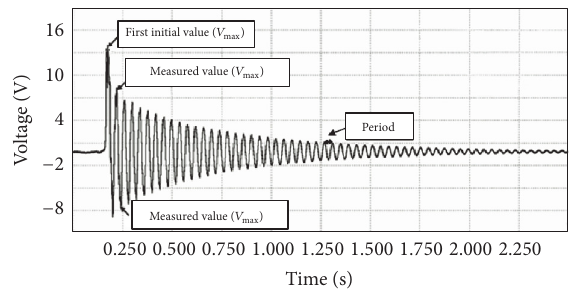
Figure 3: The time dependence of the electrical signal produced by the PZT piezoelectric energy harvester after its release.